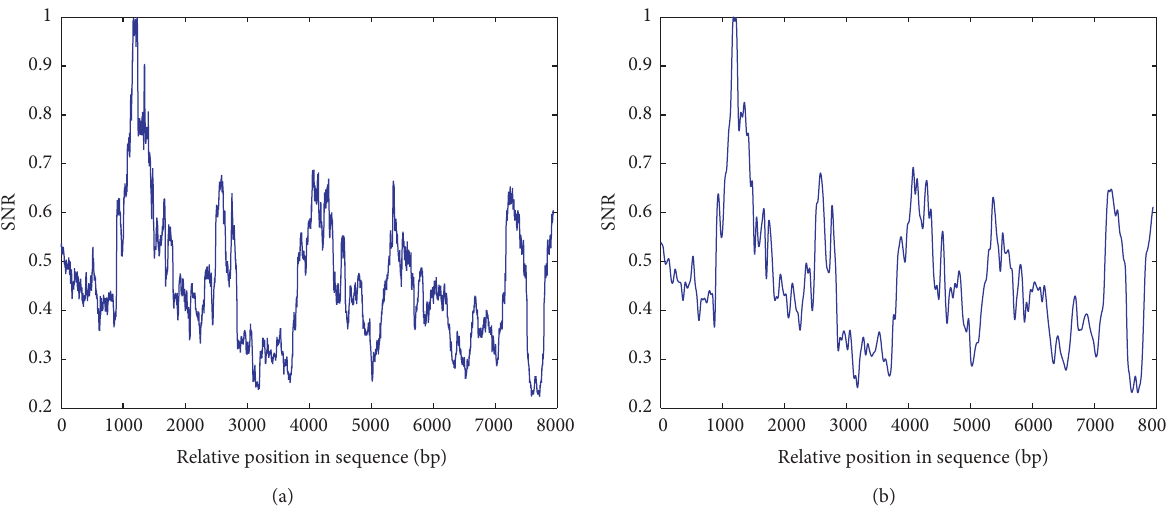
Figure6:DenoisingperformanceresultsofWPTforDNAsequenceF56F11.4.(a)TheoutputSNRofsequenceF56F11.4basedontheproposed algorithm before WPT is utilized. (b) The output SNR based on the proposed algorithm using WPT. Both methods employ the Code13 mapping method and all the other procedures are identical except whether denoising or not.